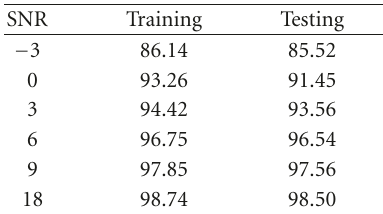
Table 4: Performances of the proposed identifier in di ff erent SNRs without optimization (%).